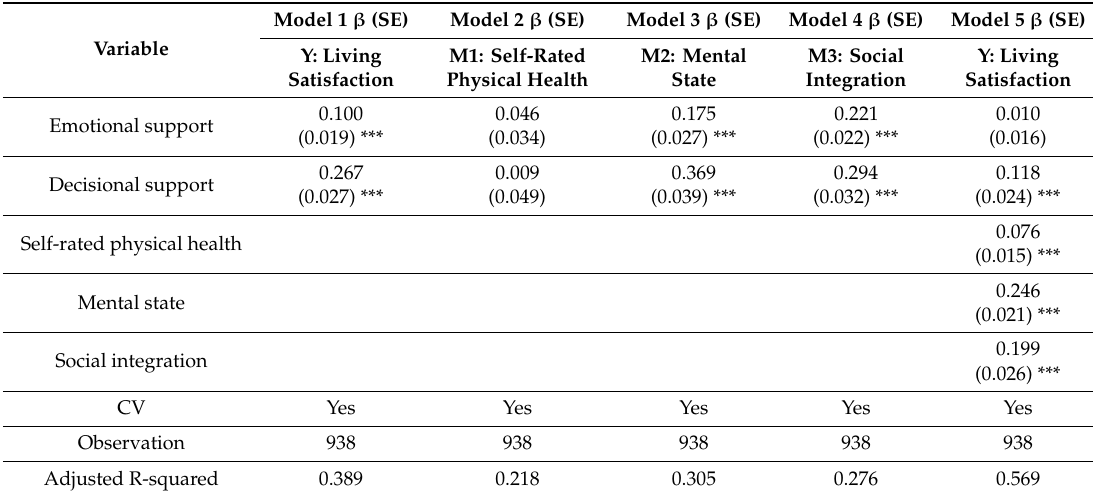
Table 5. The results of the regression and mediation